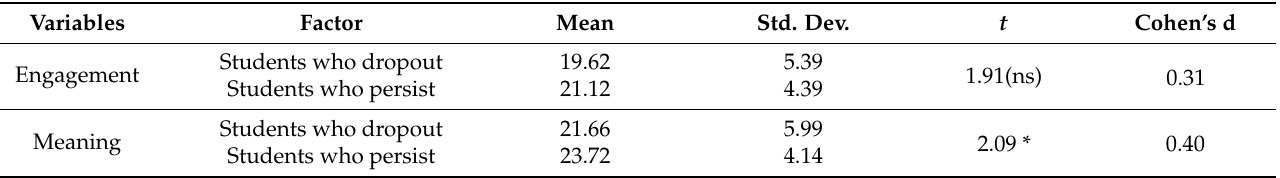
Table 8. Differences for two well-being dimensions between dropping out and persisting